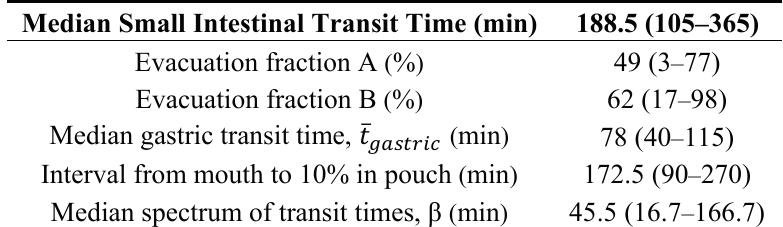
Table 2. Scintigraphic results including 20